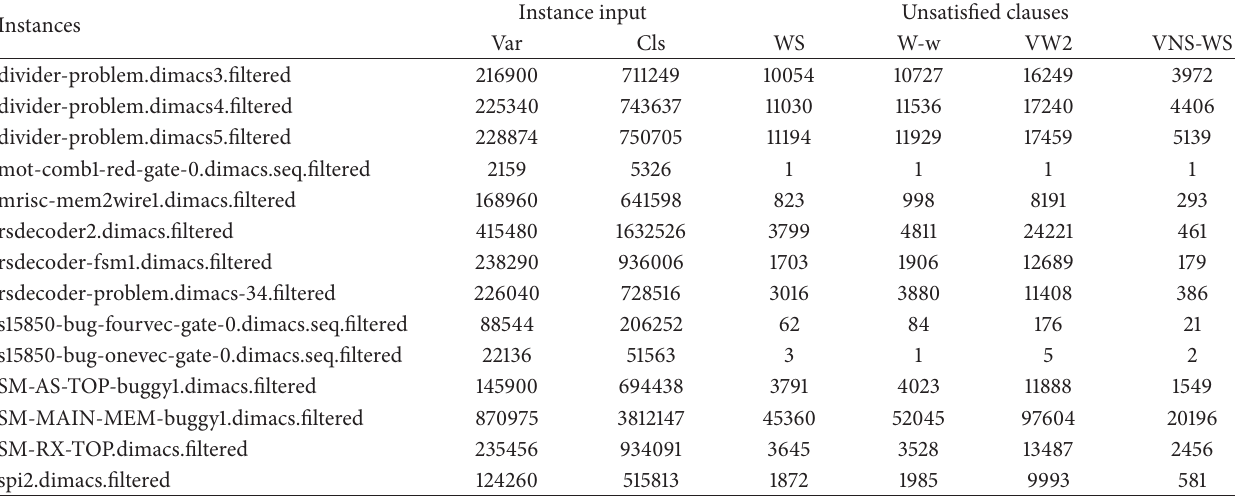
Table 3: SAT2013 industrial benchmarks: comparison among VNS-WS, WS, W-w, and VW2.